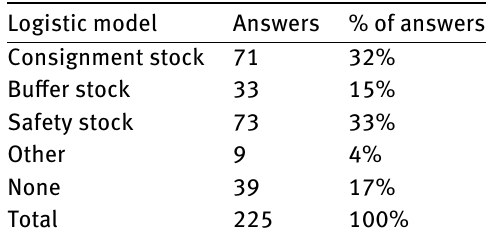
Table 1: Particular logistic models’ share in the Czech Republic.